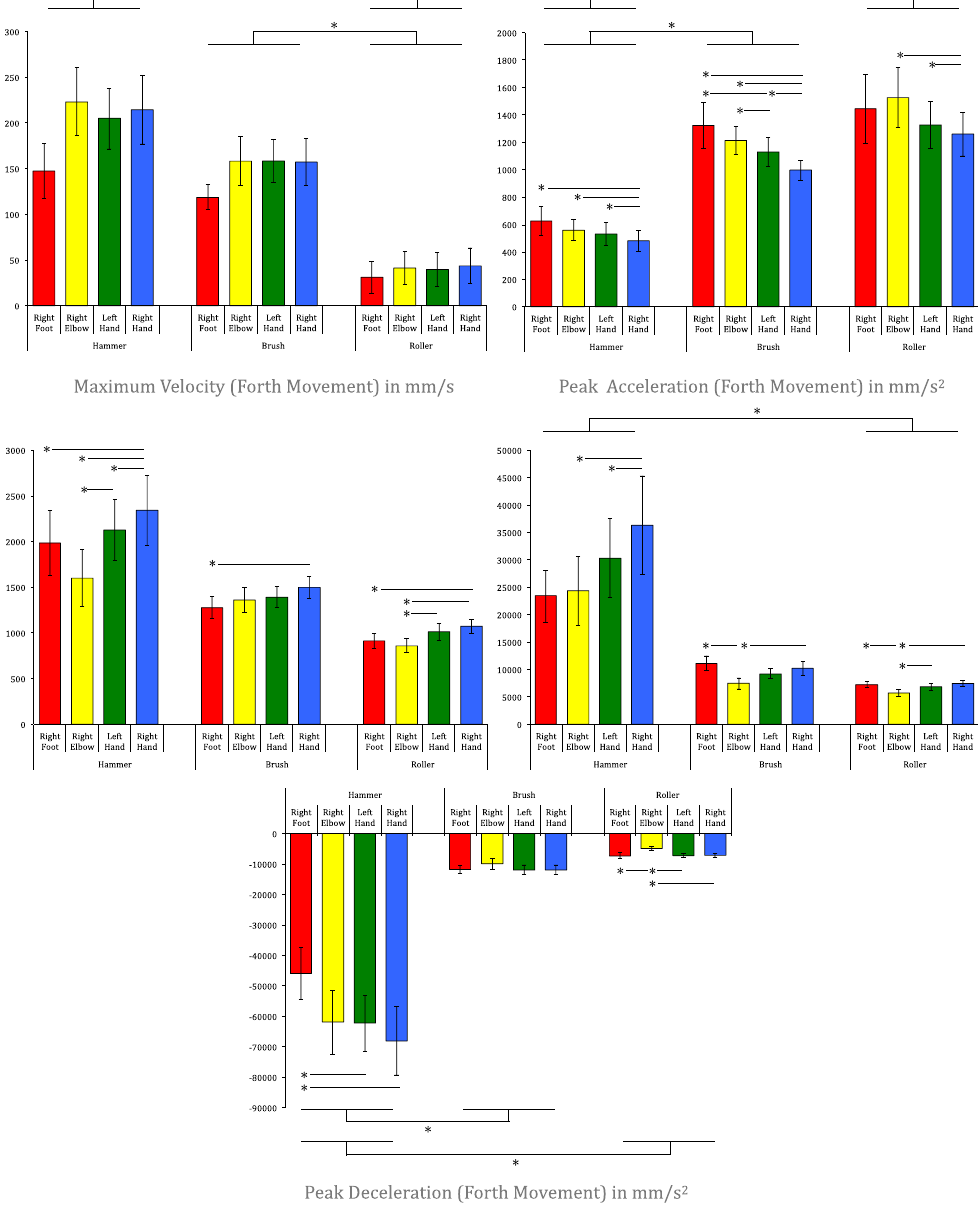
Figure 2. Spatiotemporal parameters of interest in function of tools and end-effectors. For each parameter, a one-way MANOVA with Tool as within-subject factor was conducted on the values obtained for the four end- effectors. Significant differences were found for Vertical Amplitude, Cycle Duration, Peak Acceleration, and Peak Deceleration (all F (2,27) > 2.07, all p < 0.05), but not for Maximum Velocity ( F (2,27) = 2.04, p = 0.06). When significant, post-hoc MANOVA were conducted for pairwise comparisons. Repeated-measure ANOVA with End-Effector as within-subject factor were also computed to compare the four end-effectors for each tool and each parameter. When significant, post-hoc pairwise t -tests corrected with a Holm-Bonferroni procedure were computed. Asterisks denote significant